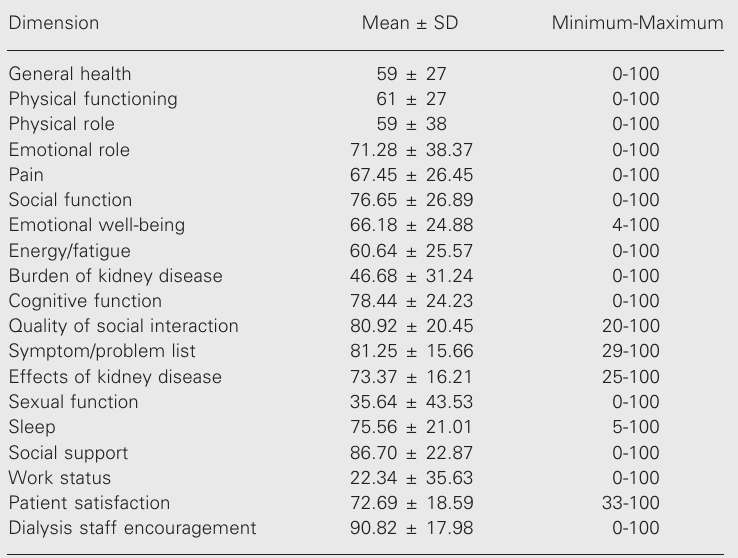
Table 1. Scores obtained for the Brazilian Portuguese version of the Kidney Disease and Quality of Life - Short Form questionnaire applied to end-stage renal disease